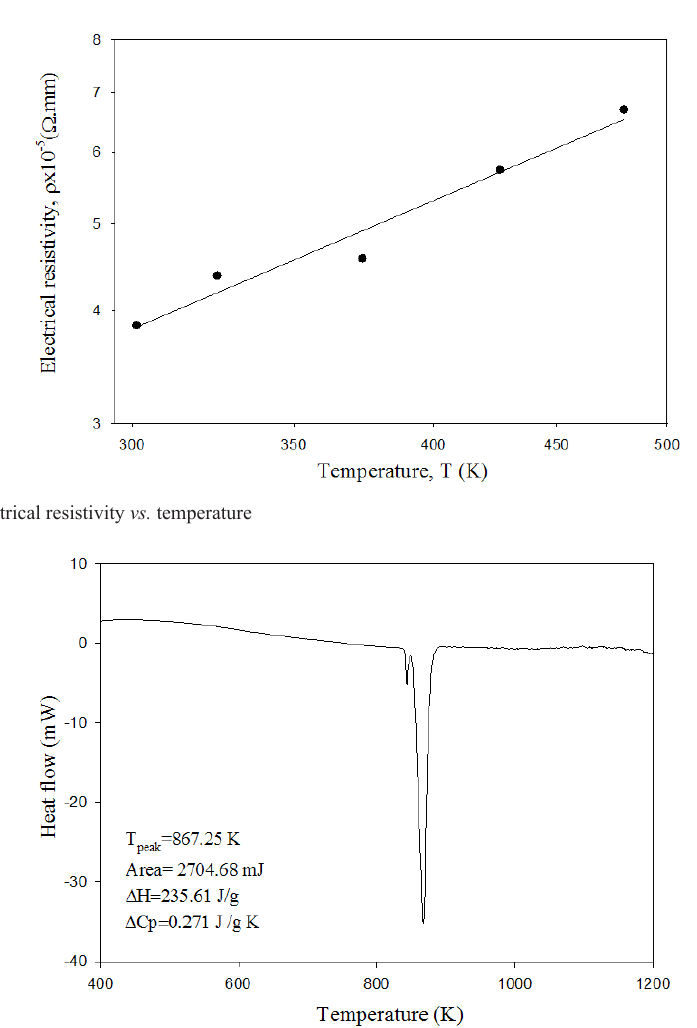
Fig. 7 Heat flow versus temperature for Al-Si-Co